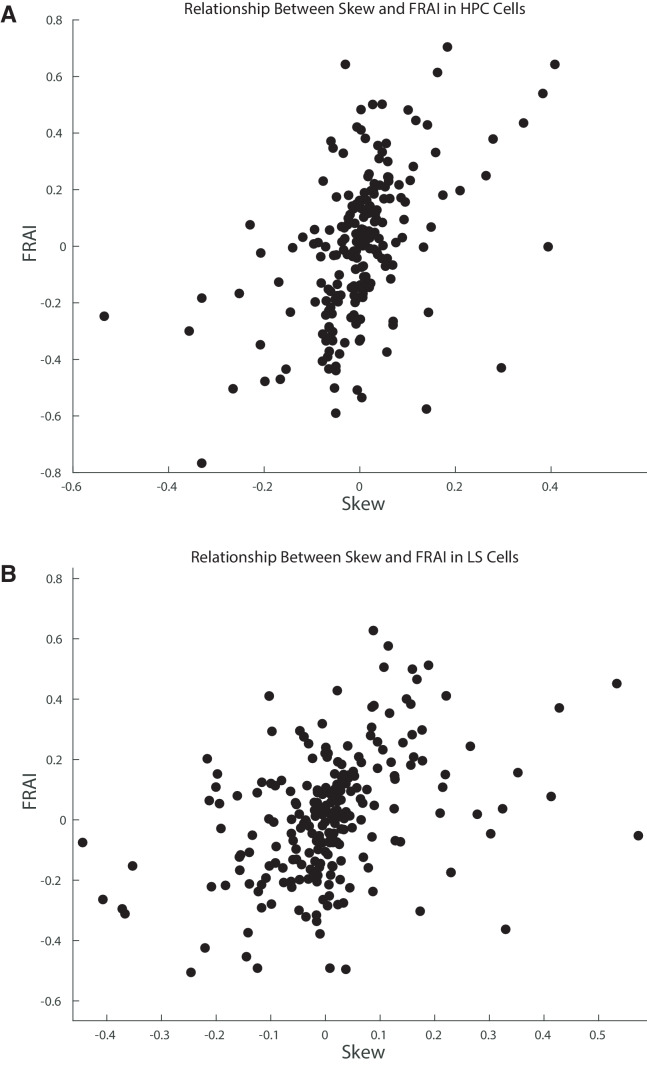
Skew and FRAI are highly linearly correlated in HPC and LS cells.(A) There is a highly significant relationship between skew and FRAI in HPC cells (f(207)=61.0, p<9-13). (B) Same as A but in LS (F(247) = 43.77, p<9-10).